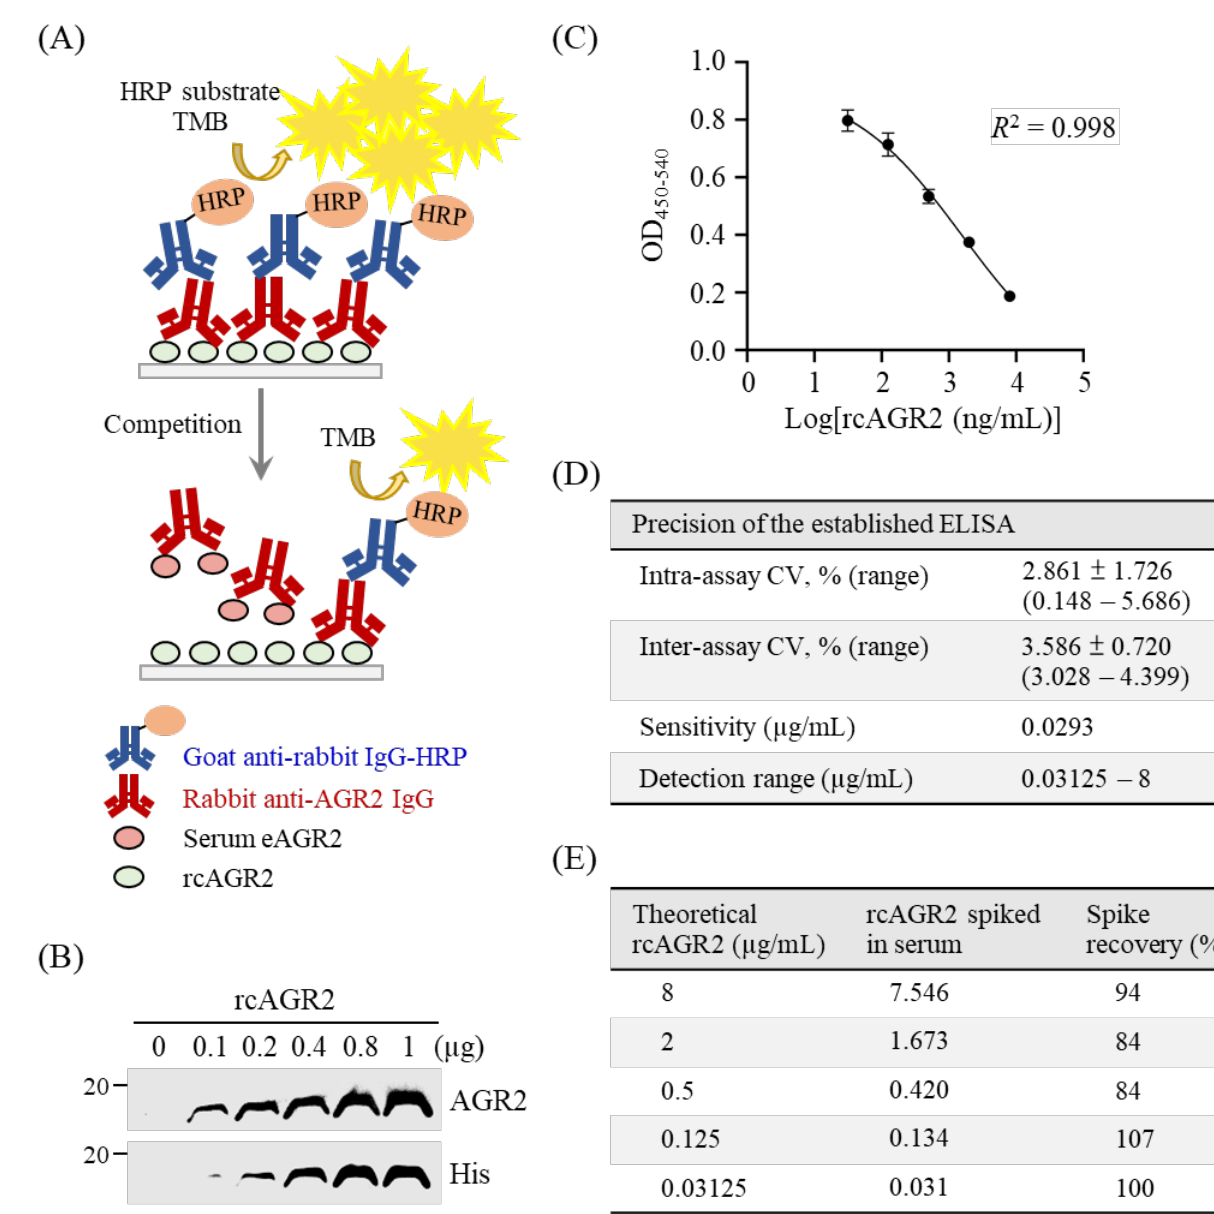
Figure 4. Establishment of a competitive ELISA for detection of serum eAGR2 in MMT dogs. ( A ) Scheme for the established competitive ELISA. ( B ) Identity of recombinant canine AGR2 (rcAGR2) was confirmed by immunoblotting using antibodies specific to AGR2 and 6 × His tag, respectively. ( C ) A standard curve with fourfold serially diluted rcAGR2 proteins (8000, 2000, 500, 125, and 31.25 ng/mL) was set for the competitive ELISA. Data are presented as the mean values ± SD across 10 assays. ( D ) Precision of the competitive ELISA. The intra-assay coefficient variant (CV), inter-assay CV, and the detection sensitivity were determined across 10 assays. ( E ) Evaluation of serum influence on eAGR2 detection in the ELISA. A spike recovery test was performed by detecting rcAGR2 spiked at indicated concentrations into canine serum containing undetectable eAGR2. The recovery rate (%) of individual spike rcAGR2 was calculated as indicated.